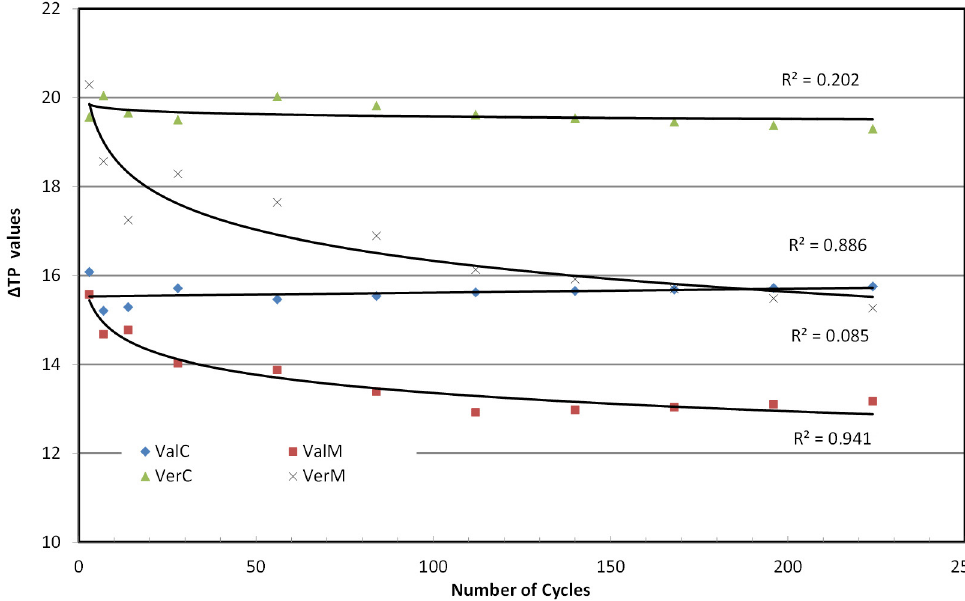
Figure 7- Trend lines for Translucency Parameter of the materials (TP units)